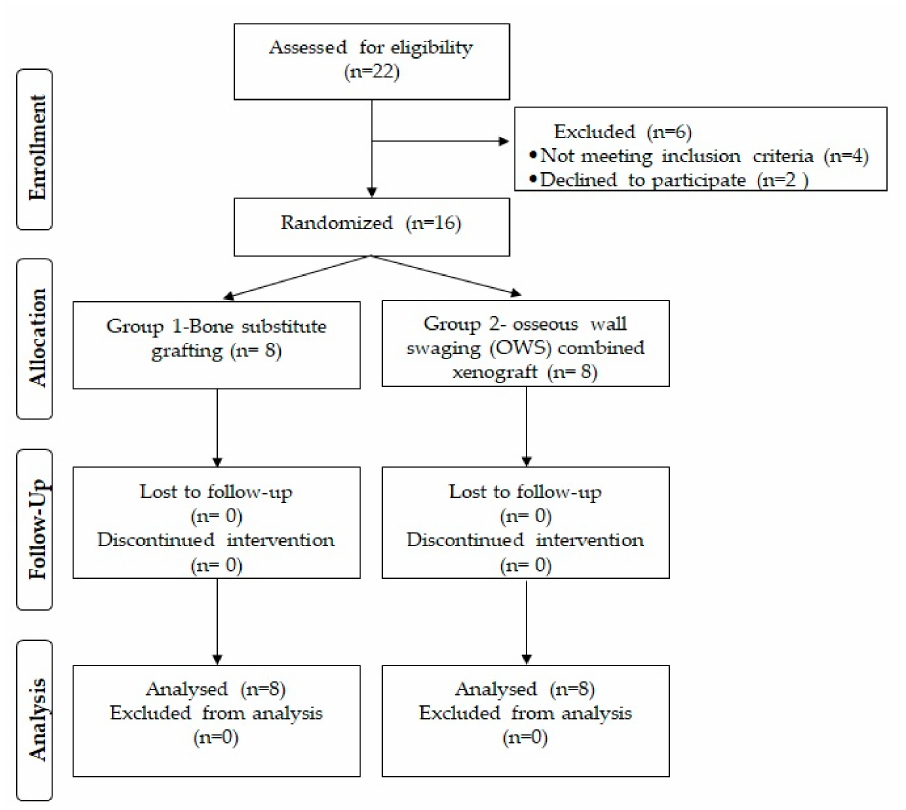
Figure 1. CONSORT flow chart of the clinical